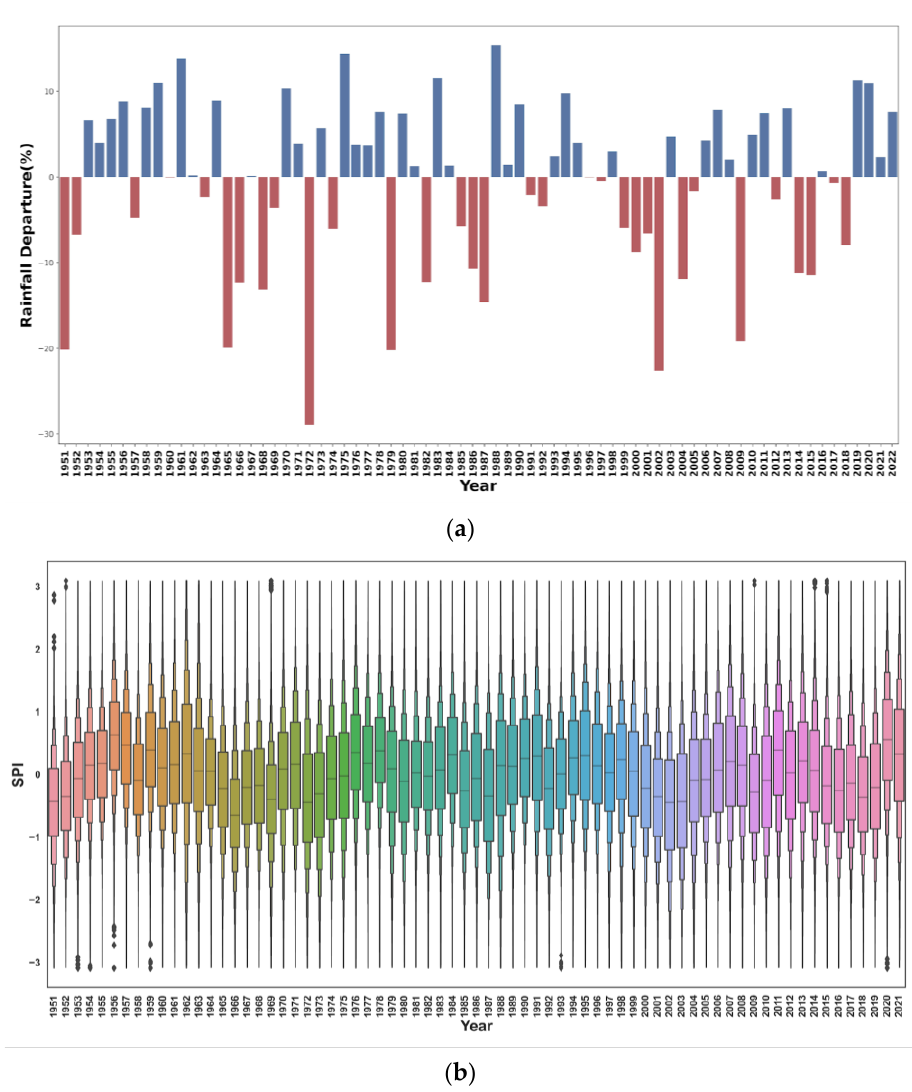
Figure 6. Interannual change in ( a ) rainfall departure in percentage (dry year in red color and wet year in blue color), ( b ) drought index (12-month Standard Precipitation Index) over Indian region for the period 1951 – 2021.